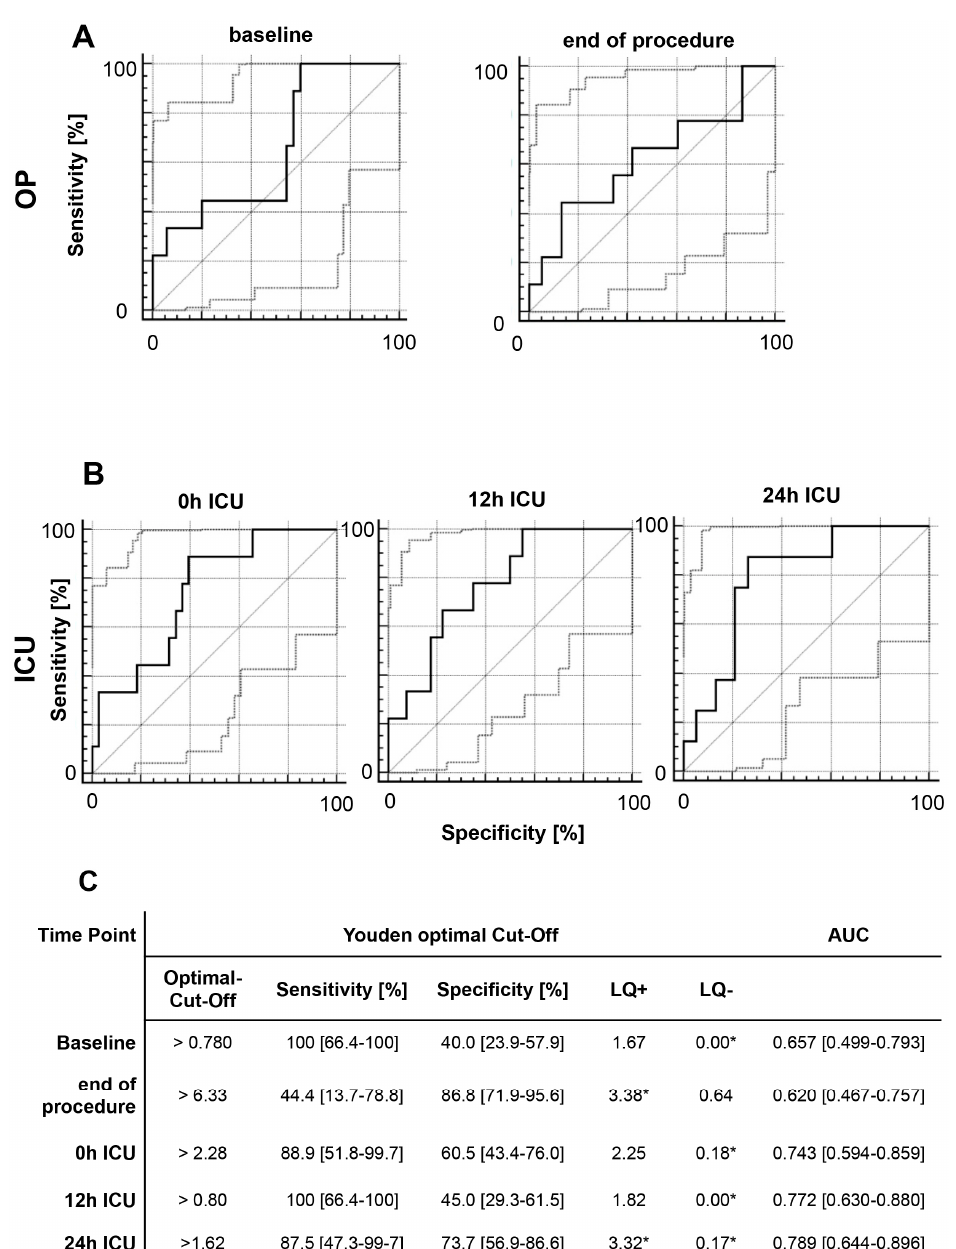
Figure 3. ROC analysis of perioperative MIF levels and patient discharge modality. ROC analysis was performed to evaluate the diagnostic capacities of ( A ) perioperative MIF levels and ( B ) MIF levels during ICU admission with regard to discharge modality. If an elevated MIF value indicates an adverse discharge modality, the ROC curve should be farther from the bisecting line (Sensitivity = 1 − Specificity). ( C ) Sensitivity (Se), speci fi city (Sp), likelihood ratios (LR +/ − ), and area under the curve (AUC) are reported for either the Youden optimal cut-o ff (maximize Se + Sp − 1) or for a sensitivity cut-off of at least 75%. * Good-to-moderate diagnostic quality: LQ+ of >3; LQ − of <0.3. * Excellent diagnostic quality: LQ+ of >10 and LQ − of >0.1.